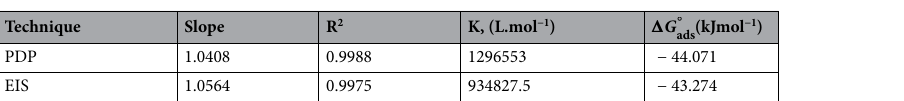
Table 4. Langmuir adsorption isotherm parameters for CS4 adsorption on CS -metal at room temperature.